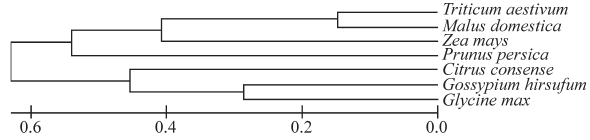
Figure 3 - Homology of the consensus sequence of citrus GS with se- quences of GS from other plants obtained from the NCBI database. The greatest similarity is among citrus, Gossypium and Glycine . Accession numbers of used sequences are Triticum aestivum DQ:124214, Malus domestica DY:256358, Zea mays X:65931, Prunus persica DY:654284, Gossypium hirsutum DT:050486 and Glycine max